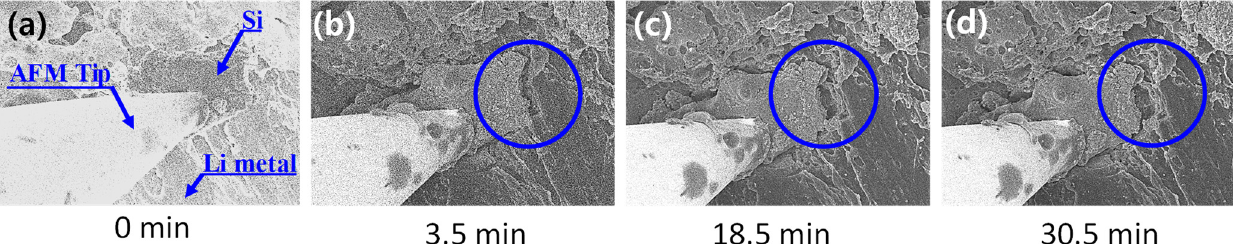
Figure 5. ( a ) Discharge capacity vs. cycle and ( b ) rate capability of STA1, STA2, and STA3.